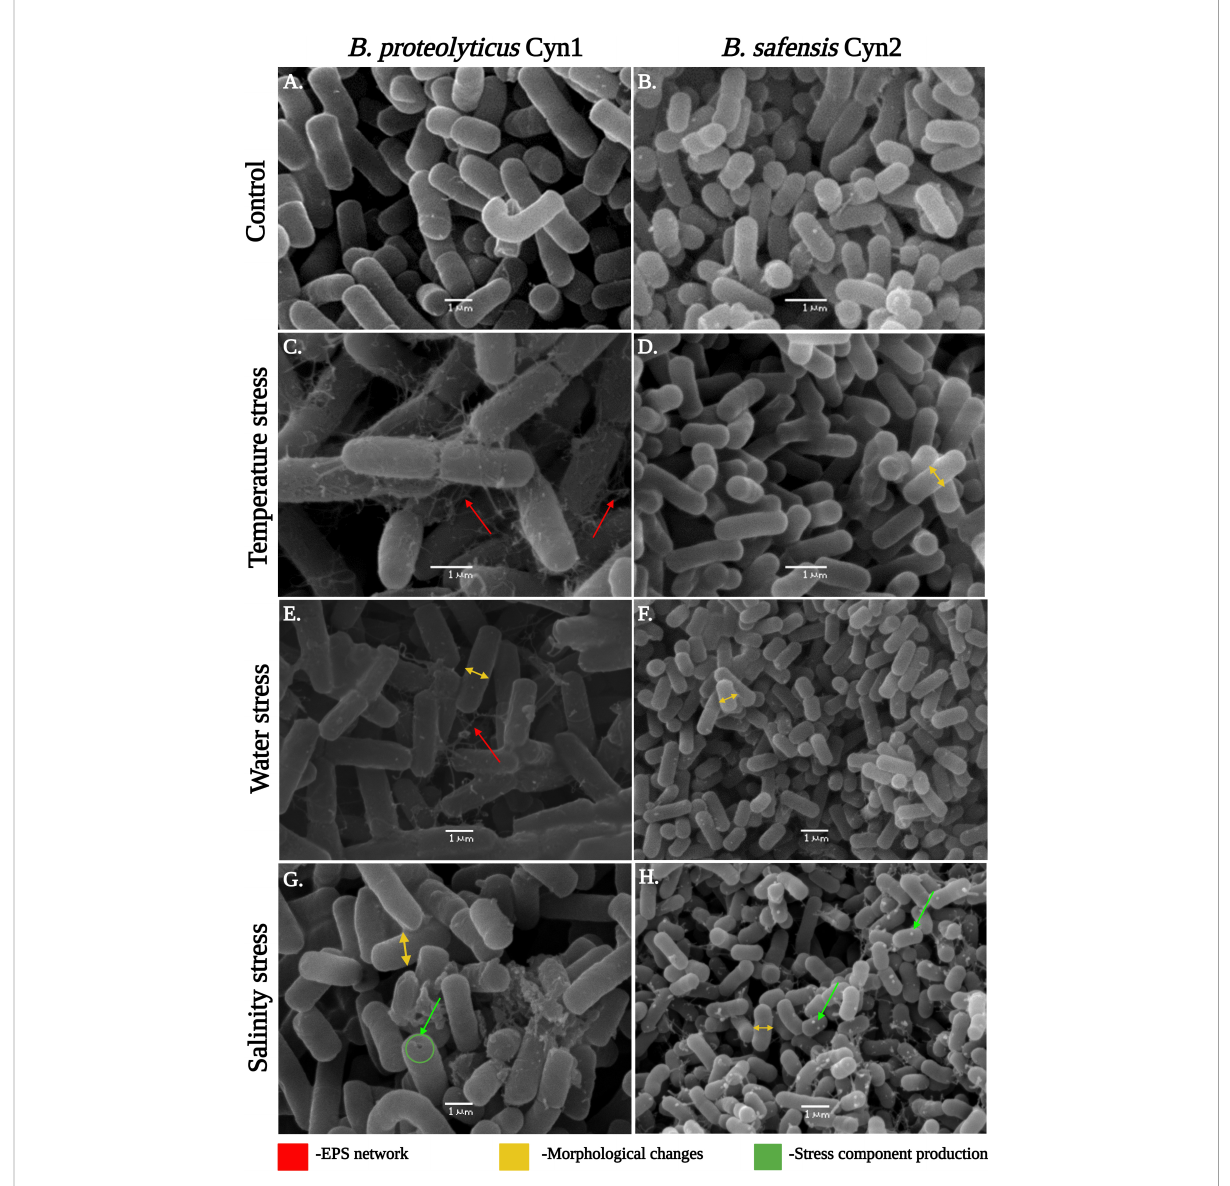
FIGURE 3 Scanning electron micrographs showing the cells of (A, C, E, G) B. proteolyticus Cyn1 and (B, D, F, H) B. safensis Cyn2 under temperature, drought, and saline conditions in comparison with the